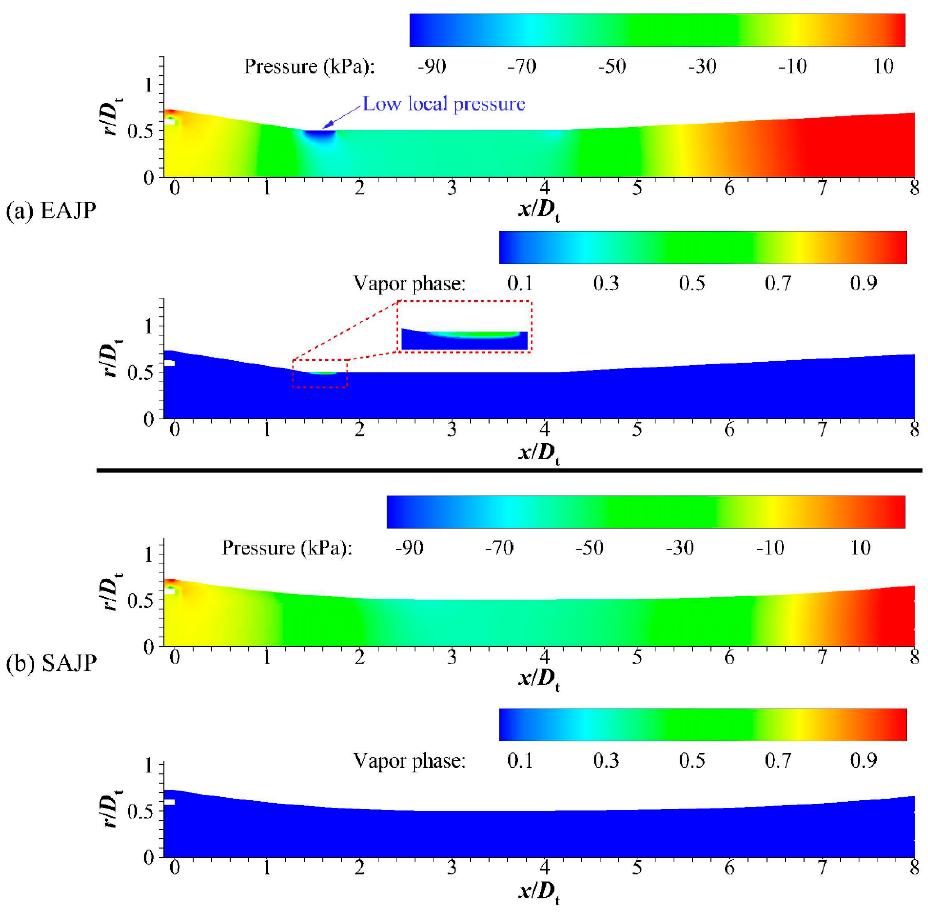
Figure 11. Pressure and vapor volume fraction distribution ( q = 0.53). Energies 2020 , 13 , 4411